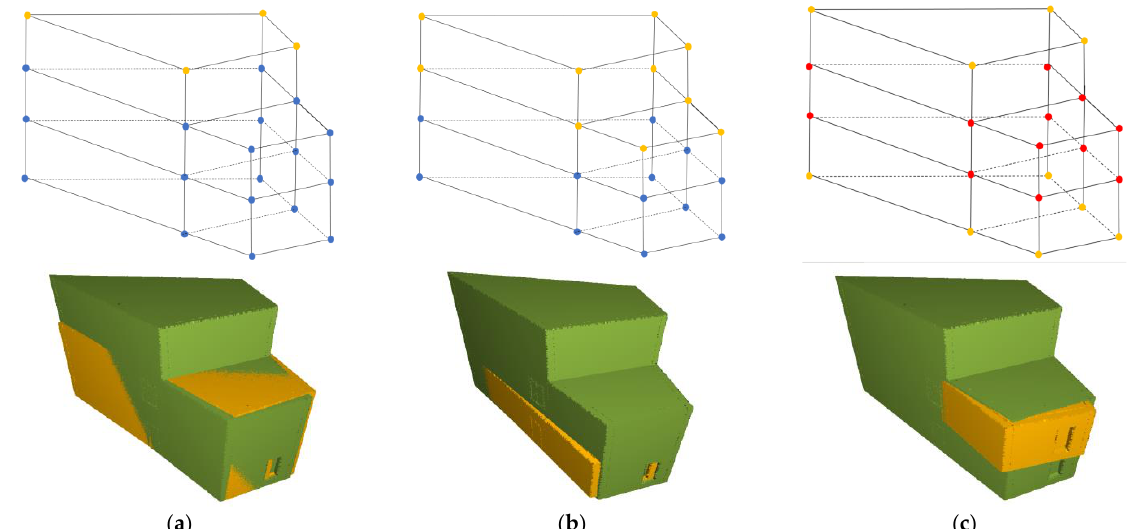
Figure 18. Visualization of registered incomplete as-built (yellow) with as-planned (green) models according to their respective extracted corner points shown above ( a – c